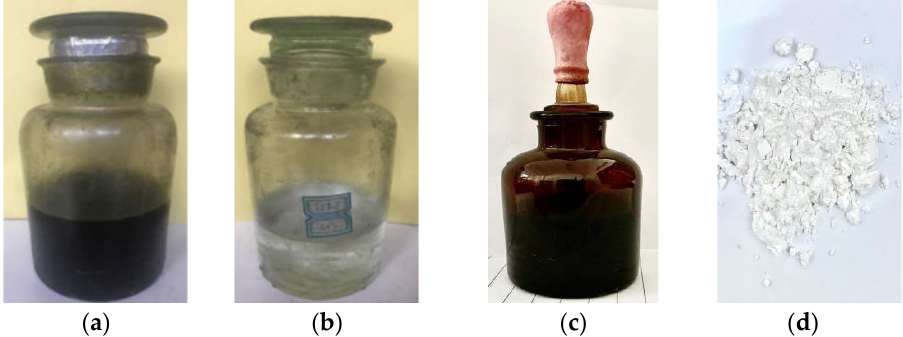
Figure 1. Raw materials: ( a ) WANNATE ®® PM ‐ 200 Isocyanate; ( b ) ES305 polyether polyol; ( c ) KOSMOS ‐ 29 Stannous Octoate; ( d ) HQEE chain extender.